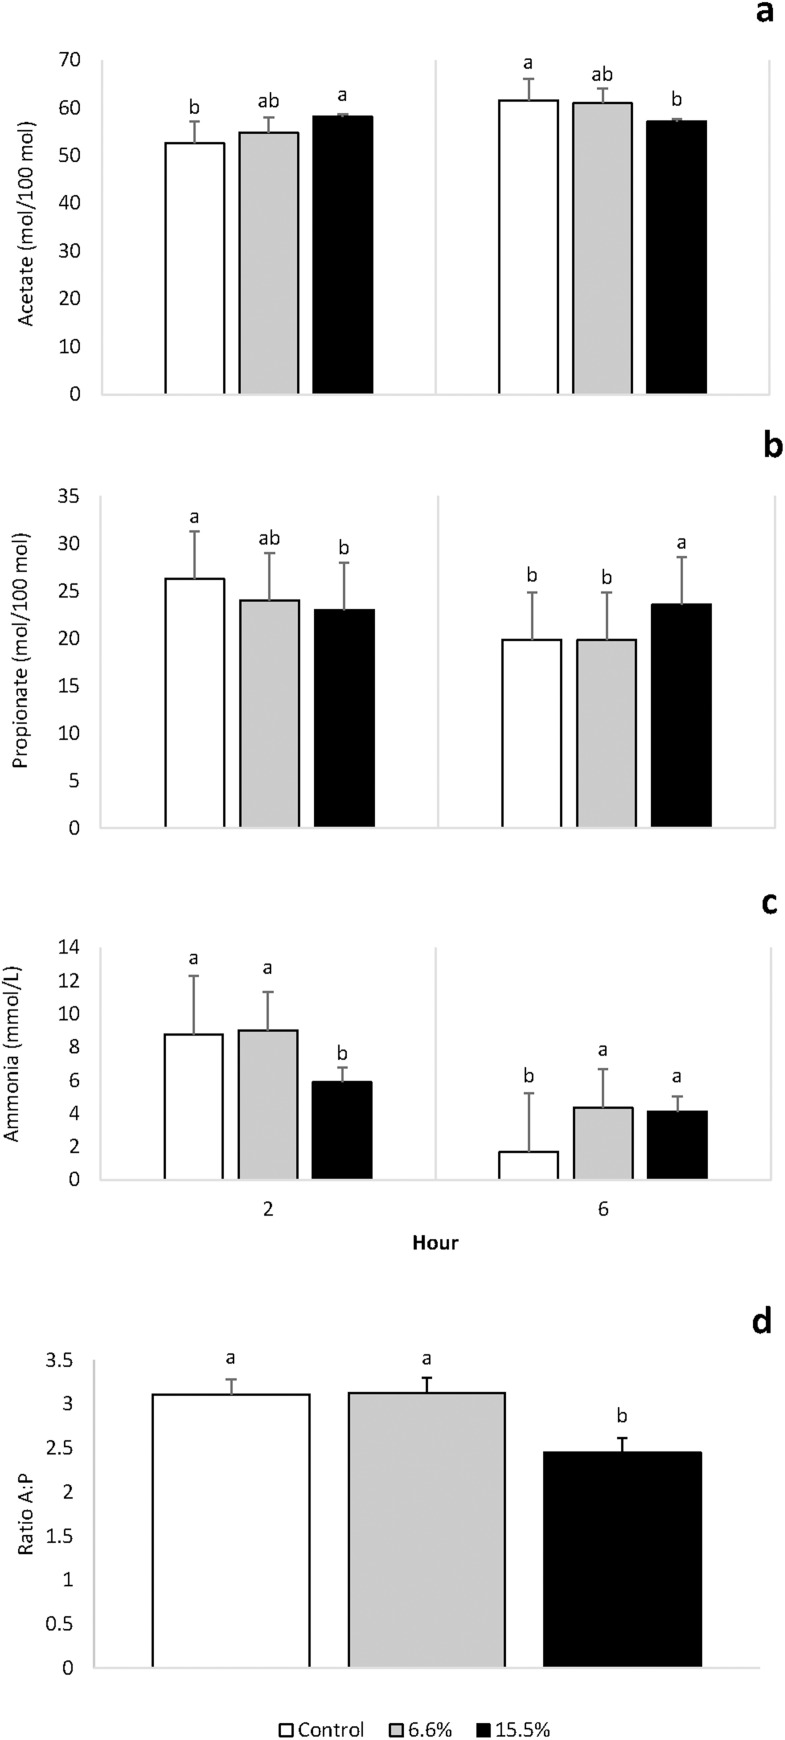
Concentrations of VFAs present in ruminal fluid taken from dairy cows fed a forage mixed ration supplemented with Tithonia diversifolia which replaced other feed ingredients a: Acetate at 2 h and 6 h after feeding, b: propionate 2 h and 6 h after feeding, c: acetate:propionate 6 h after feeding, d: ammonia 2 h and 6 h after feeding.